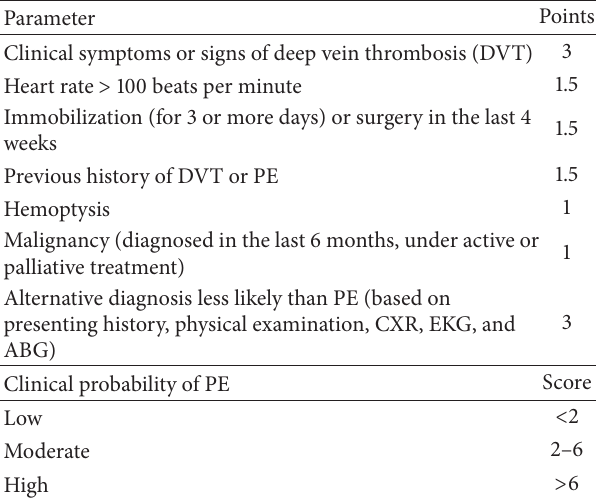
Table 1: Wells’ simplified clinical prediction model.